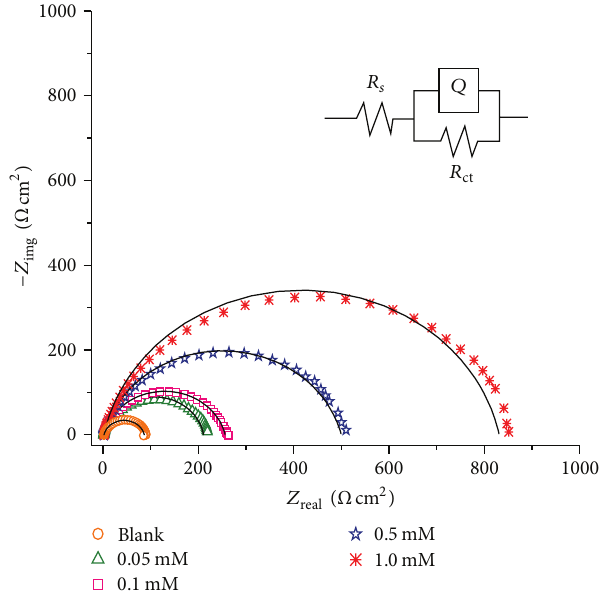
Figure 8: Nyquist plot (solid line shows fitted results) of mild steel in 1M HCl solution without and with different concentrations of RS.